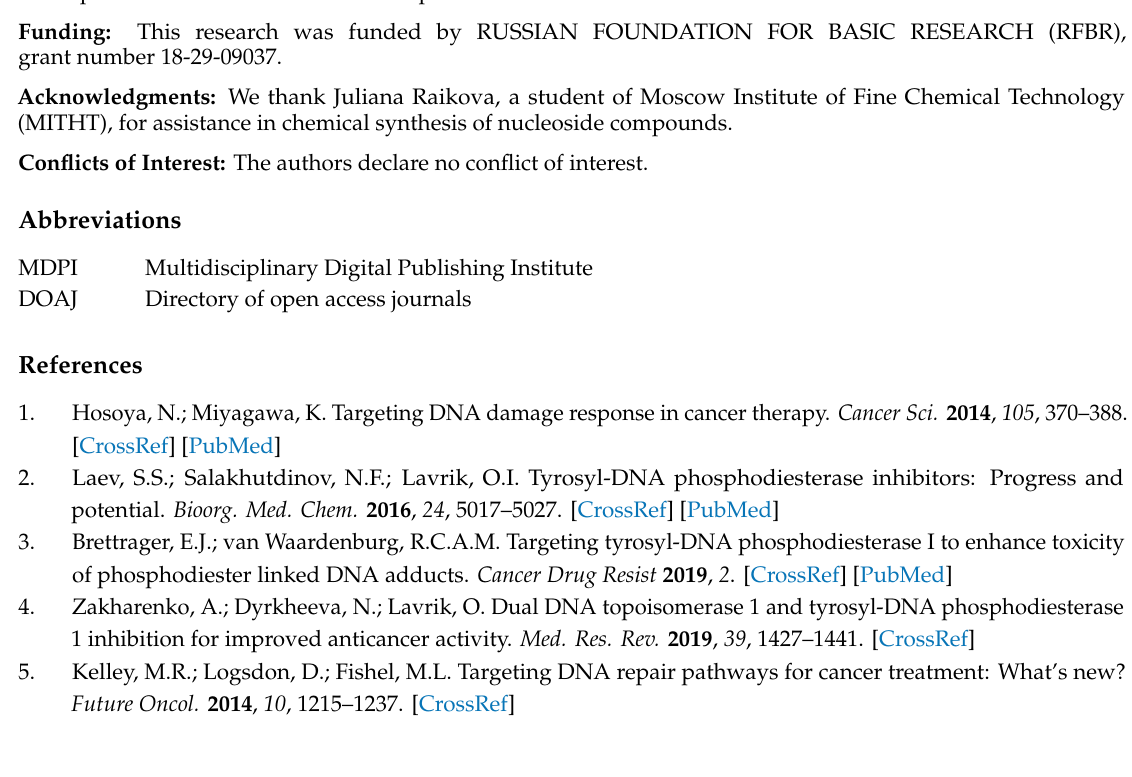
Figure S15: Dose-dependent action of the lipophilic pyrimidine nucleosides on HeLa cell viability measured in the EZ4U assay, Figure S16: Dose-dependent action of the lipophilic nucleosides in combination with topotecan (Tpc) on HeLa cell viability in the EZ4U assay, Figure S17: Dose-dependent action of topotecan (Tpc) in combination with one of the nucleoside derivatives on HeLa cell viability in the EZ4U assay, Figure S18: Correlation diagram between Tdp-1 inhibition IC 50 and logP of nucleoside derivatives for compounds 2a – 2g , 4a , 5 – 9 , Figure S19: Structure-activity relationship between Tdp-1 inhibition and the quantity of benzoyl groups in nucleoside ribofuranose